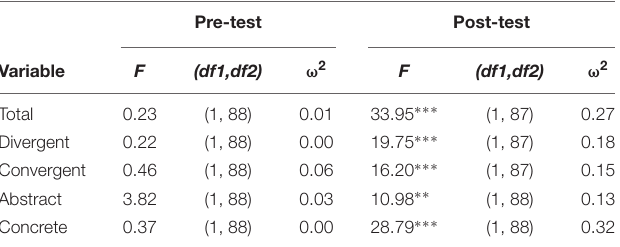
TABLE 6 | Main between subjects effect of group by